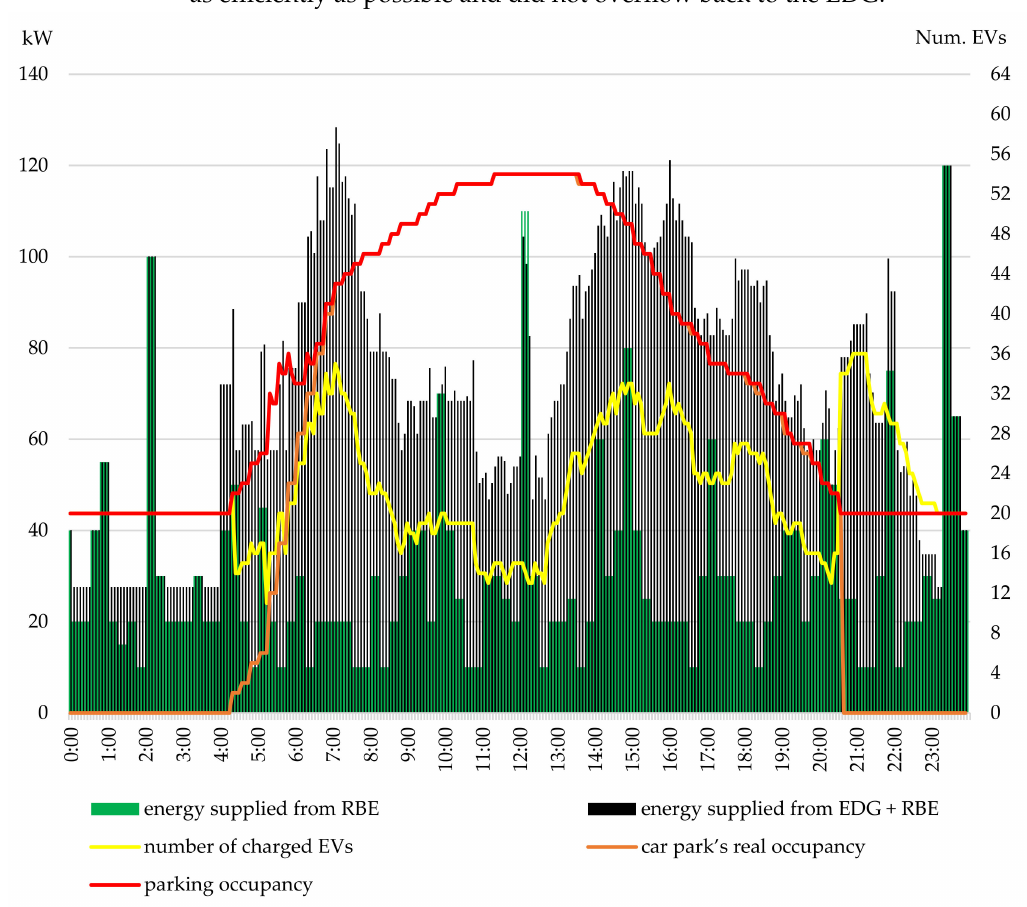
Figure 8. Average electricity consumption in the car park during